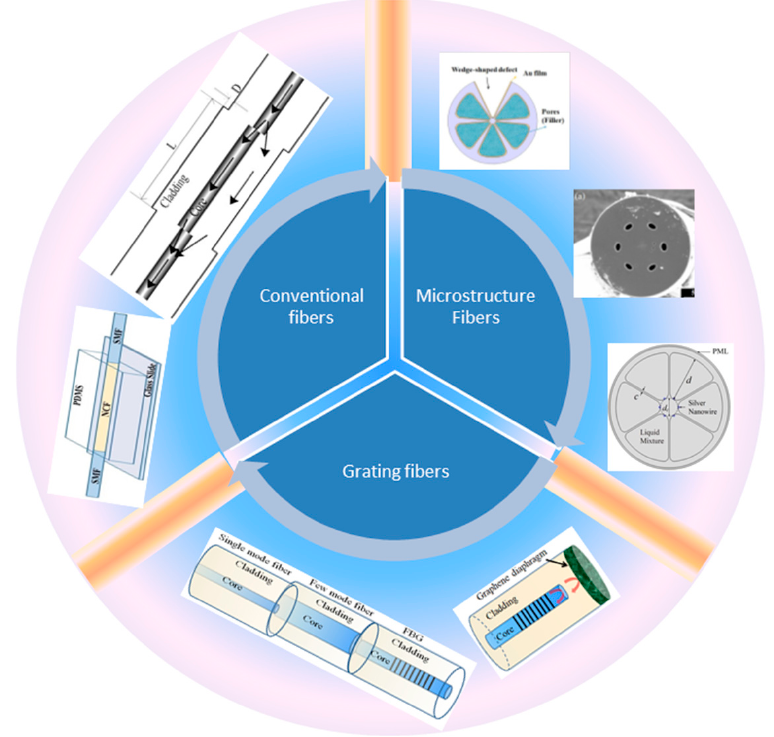
Figure 1. Summary of various optical fiber-based temperature sensors.